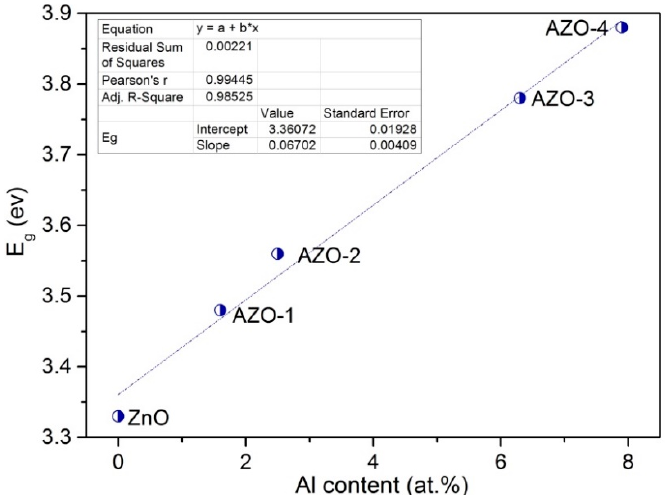
Figure 12. Optical band gap as a function of Al content in the analyzed films.